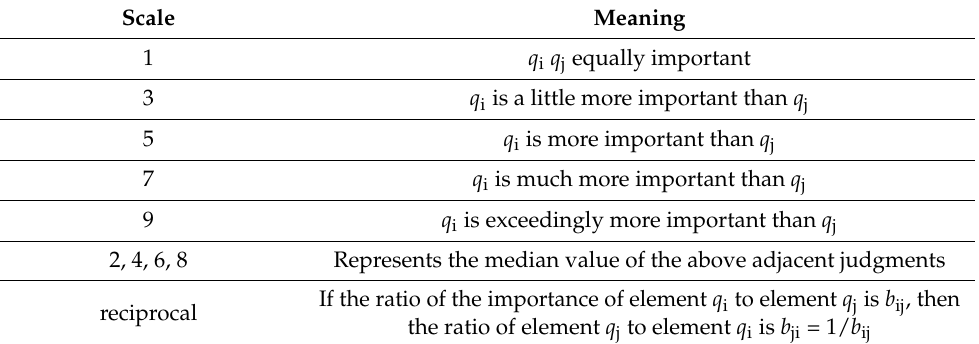
Table 1. Meanings of scales 1 to 9 in the AHP. Scale